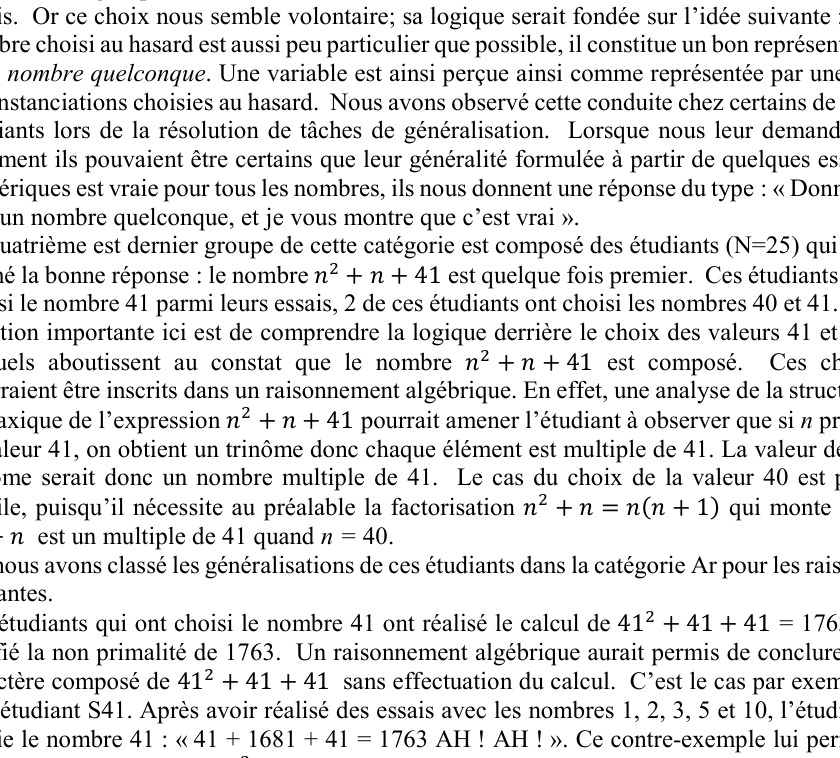
Tableau 3 : Répartition des réponses dans les deux catégories Ar et